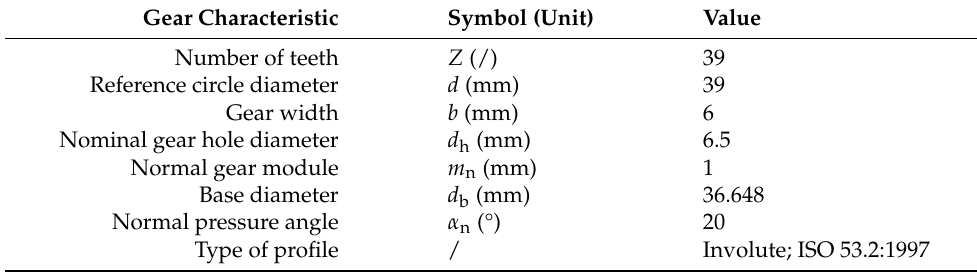
Table 2. Gear design characteristics per standard